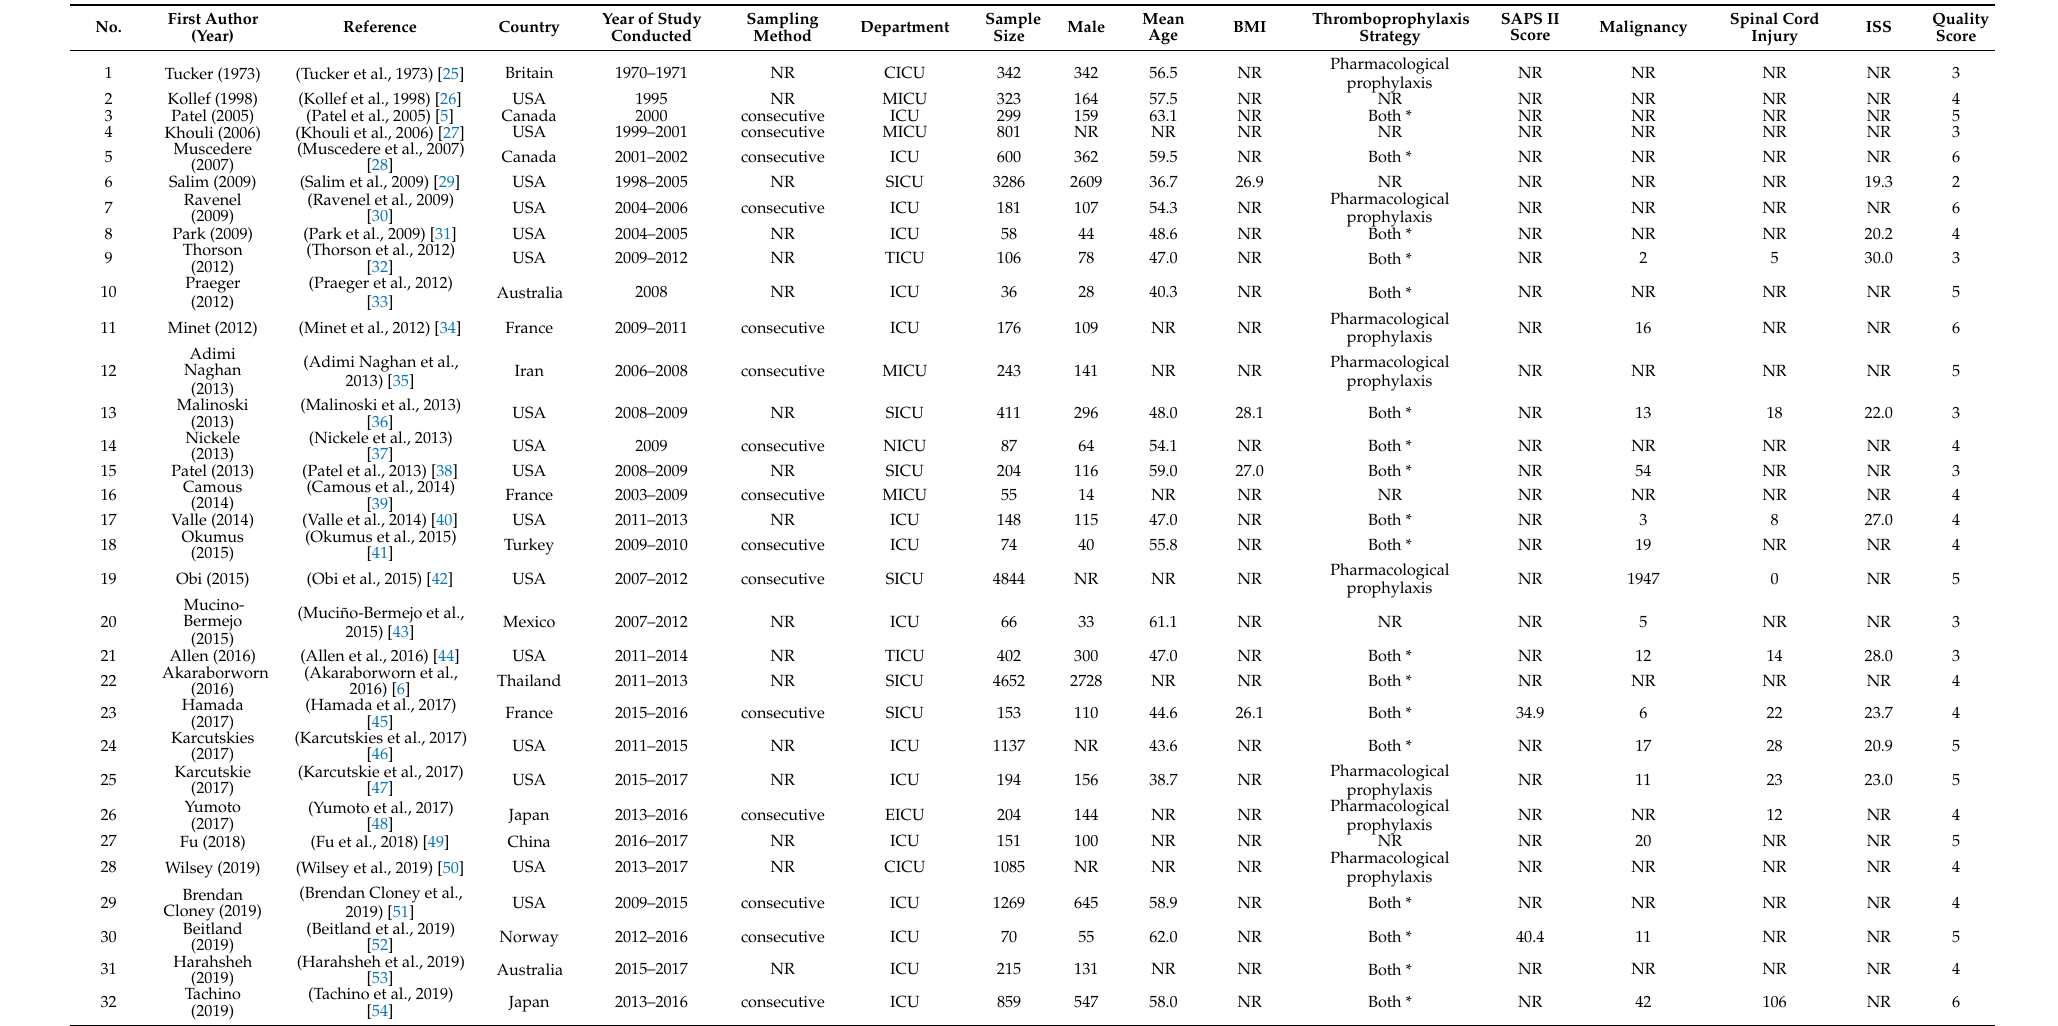
Table 1. Characteristics of studies included in this